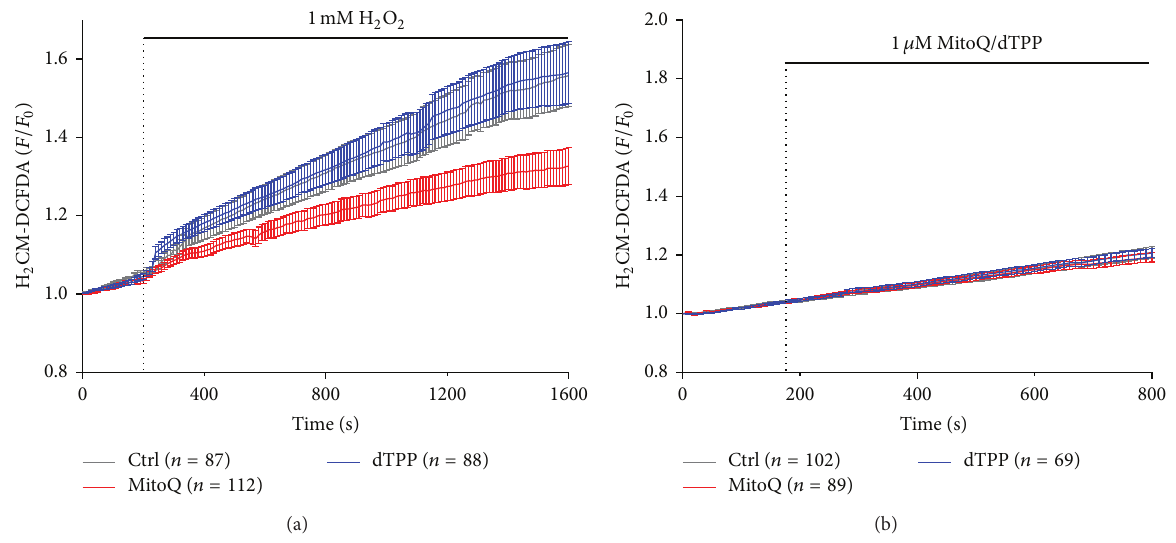
Figure 1: Effects of MitoQ on ROS responses in isolated pancreatic acinar cells. (a) 1mM H 2 O 2 induced a steady rise of intracellular ROS production, indicated by an increase in DFDCA fluorescence, which was significantly reduced by 1 𝜇 M MitoQ but not dTPP. (b) Neither 1 𝜇 M MitoQ nor dTPP caused ROS production per se . ( 𝑛 ≥ 3 mice per group). DCFDA fluorescent traces are shown as normalised ( F / F 0 ) mean ±